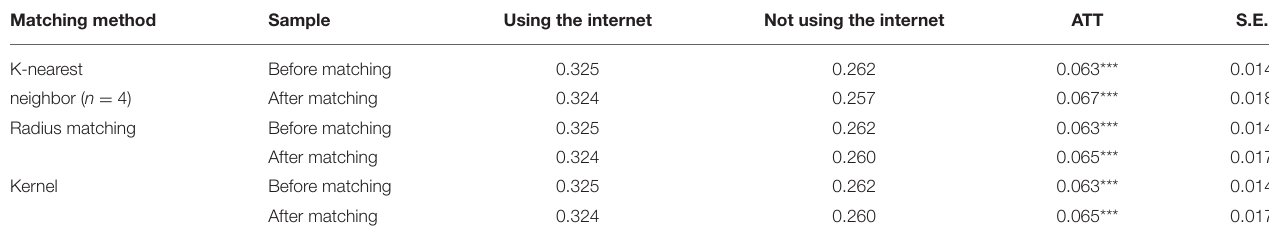
TABLE 5 | Propensity score matching estimation for effect of smartphone use on mental health. Matching